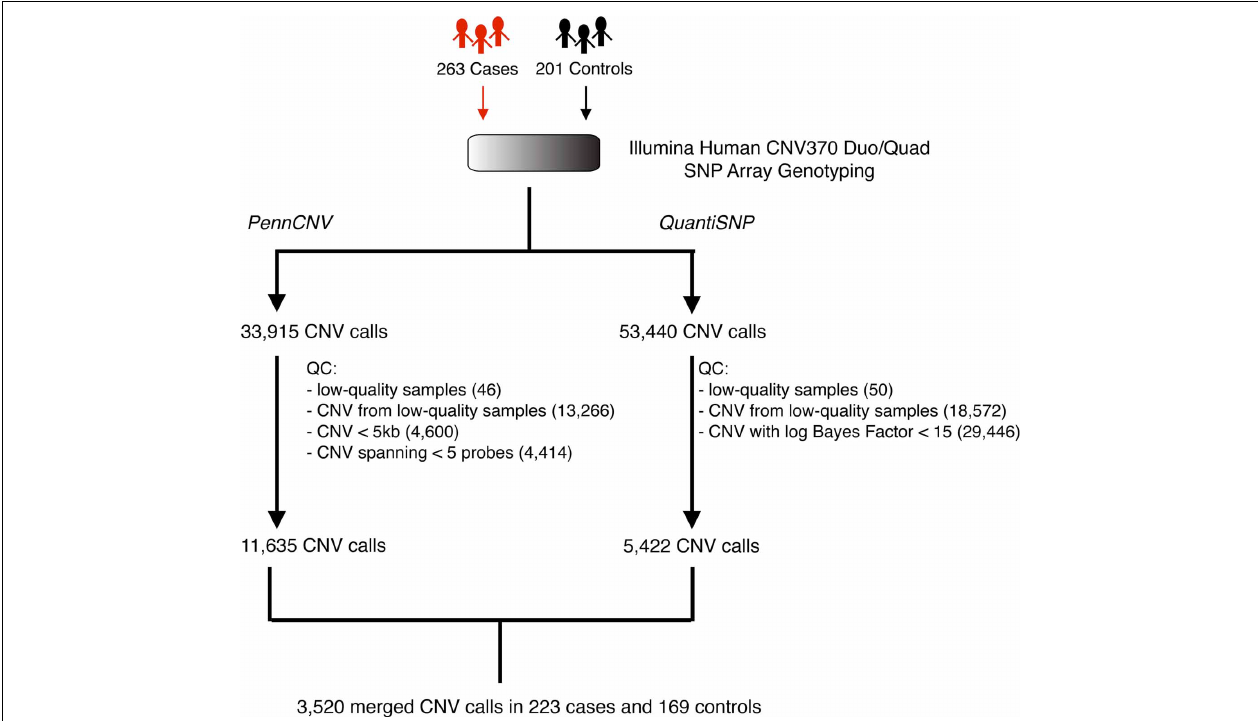
FIGURE 2 | Schematic overview of the CNV discovery pipeline. Whole-genome SNP array genotyping was applied to the germline DNA of 263 pancreatic cancer patients (cases) and 201 healthy individuals (controls). Following normalization, probe intensities were analyzed separately by two